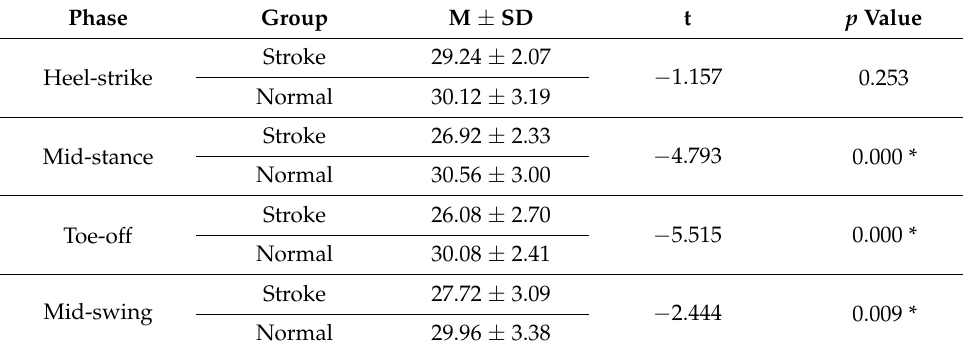
Table 2. The H-reflex latencies during walking according to group